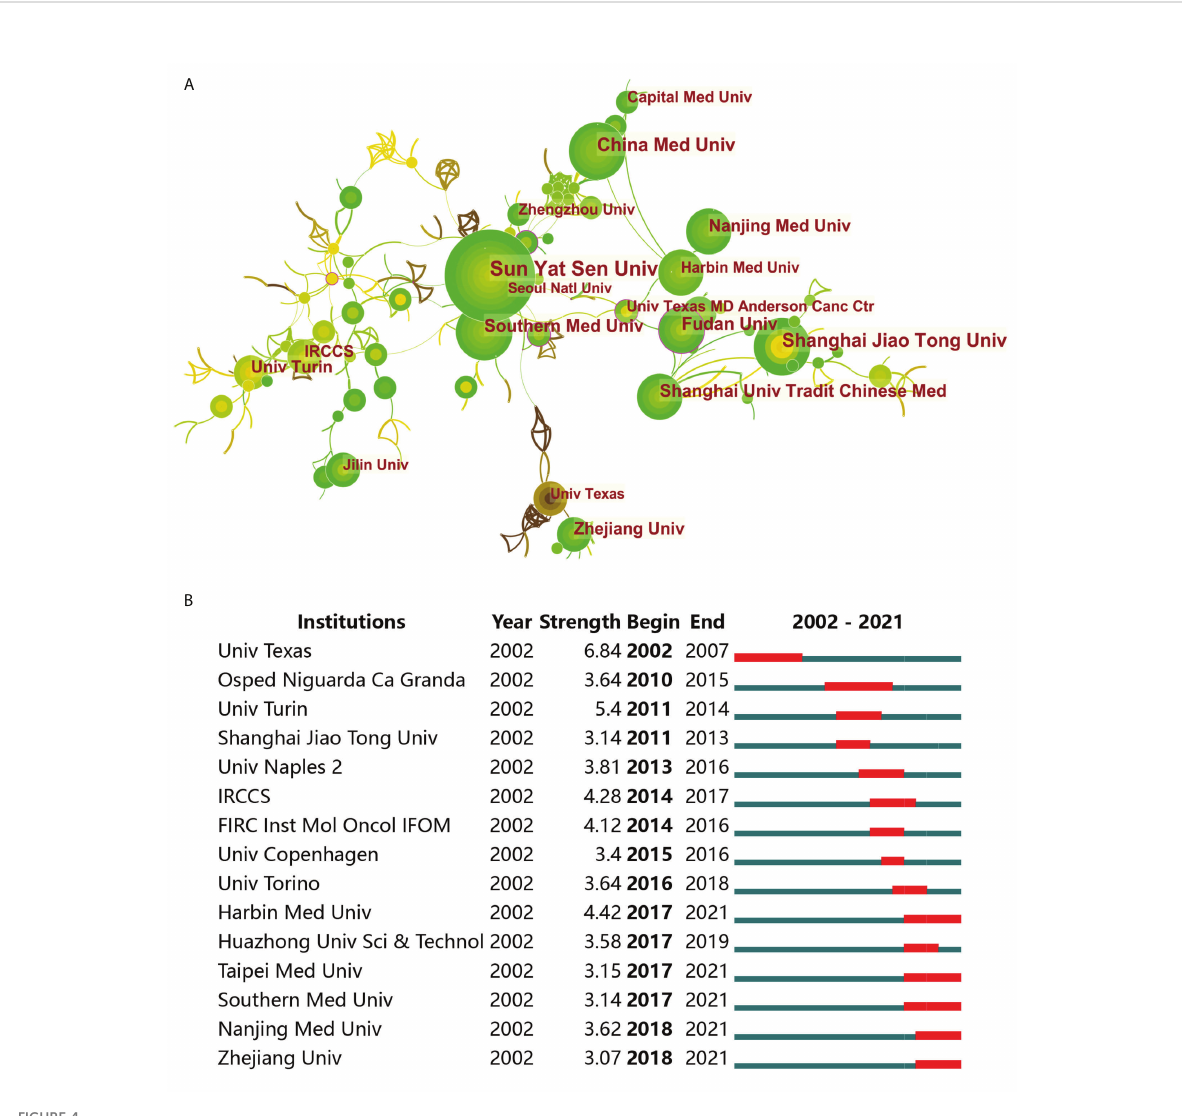
FIGURE 4 The contributions of different institutions associated with drug resistance and colorectal cancer. (A) Global institutions collaboration analysis. The nodes represent institutions, and the lines mean connection between them. The publication number is proportional to the size of nodes, and the thickness of the connecting line is proportional to the degree of cooperation. (B) Top 15 institutions with the strongest citation bursts. The blue line represents the time axis, and the red portion on the blue time axis represents the interval at which the burst was found, including the start year, end year, and burst